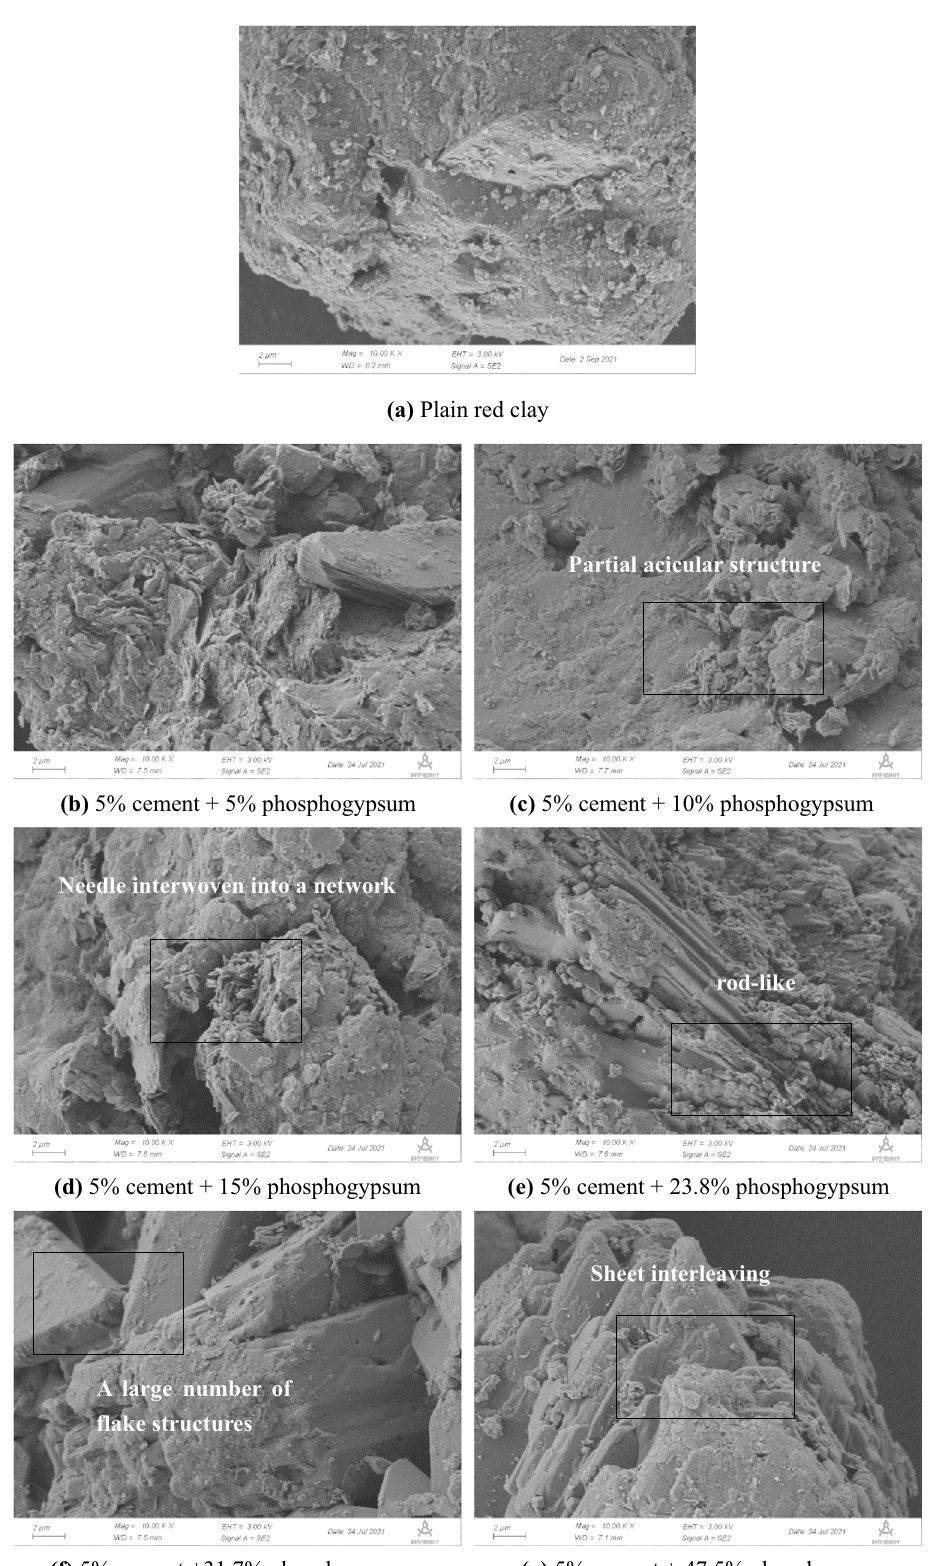
Fig. 13 SEM photos of plain red clay and phosphogypsum modified